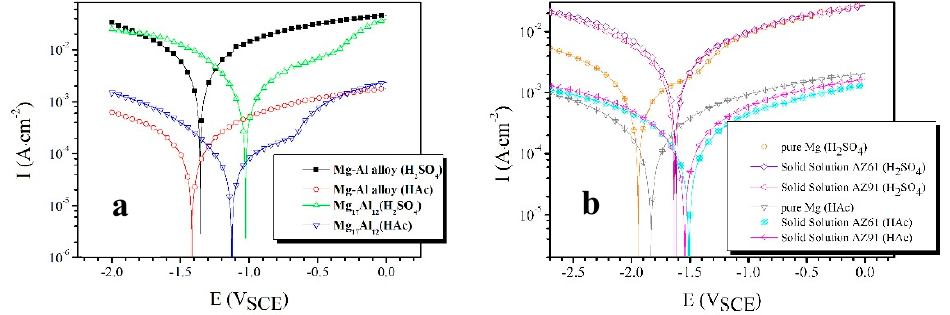
Table 2. Electrochemical parameters obtained from polarization curves in H 2 SO 4 and acetic acid (HAc) solutions.